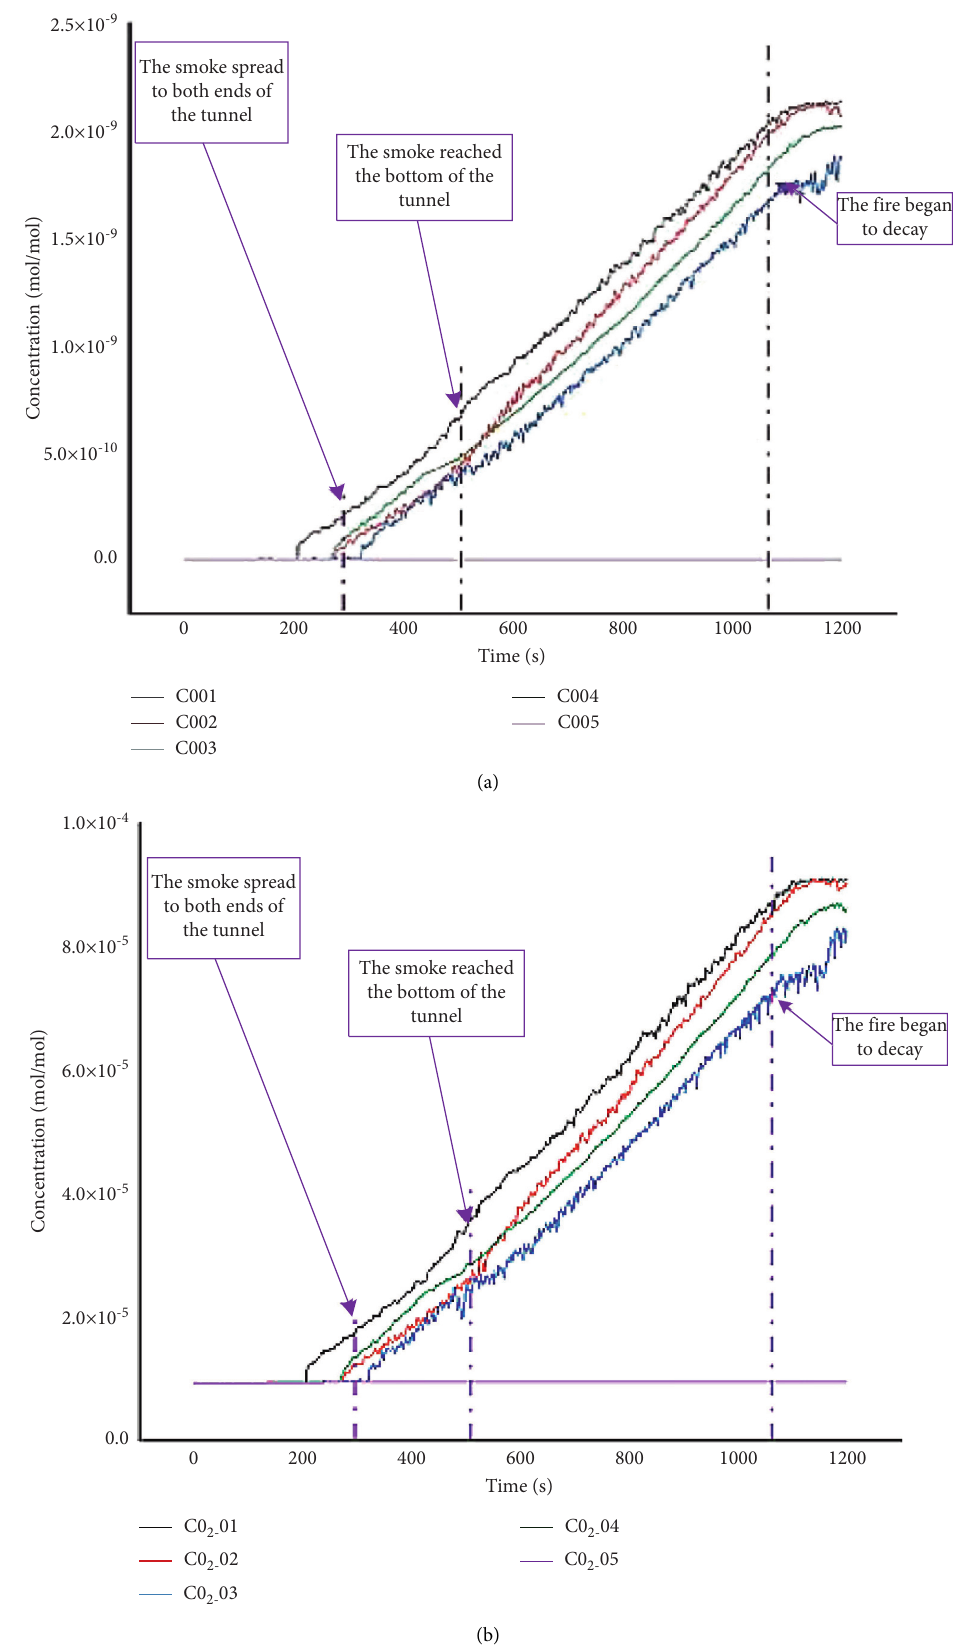
Figure 2: Comparison of smoke concentration changes under working condition 1. (a) Carbon monoxide concentration. (b) Carbon dioxide